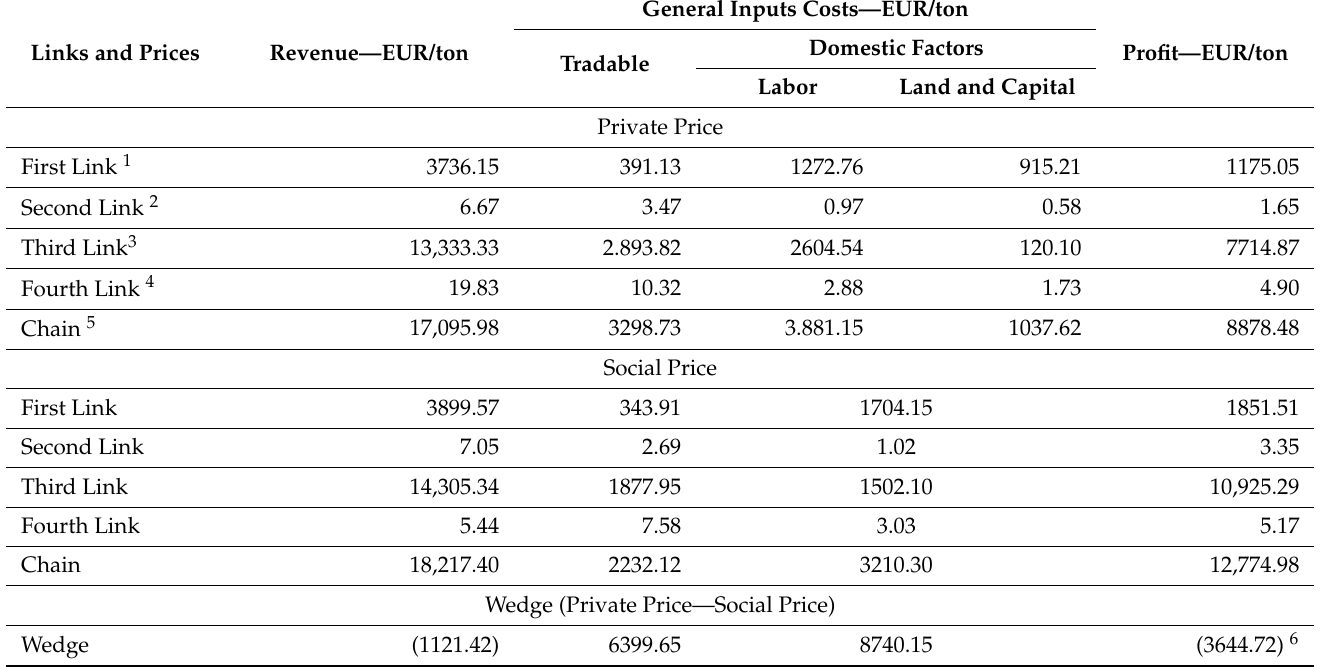
Table 4. Competitiveness and comparative advantage indicators and policy impact coefficients for the EVOO AGS in Brazil.